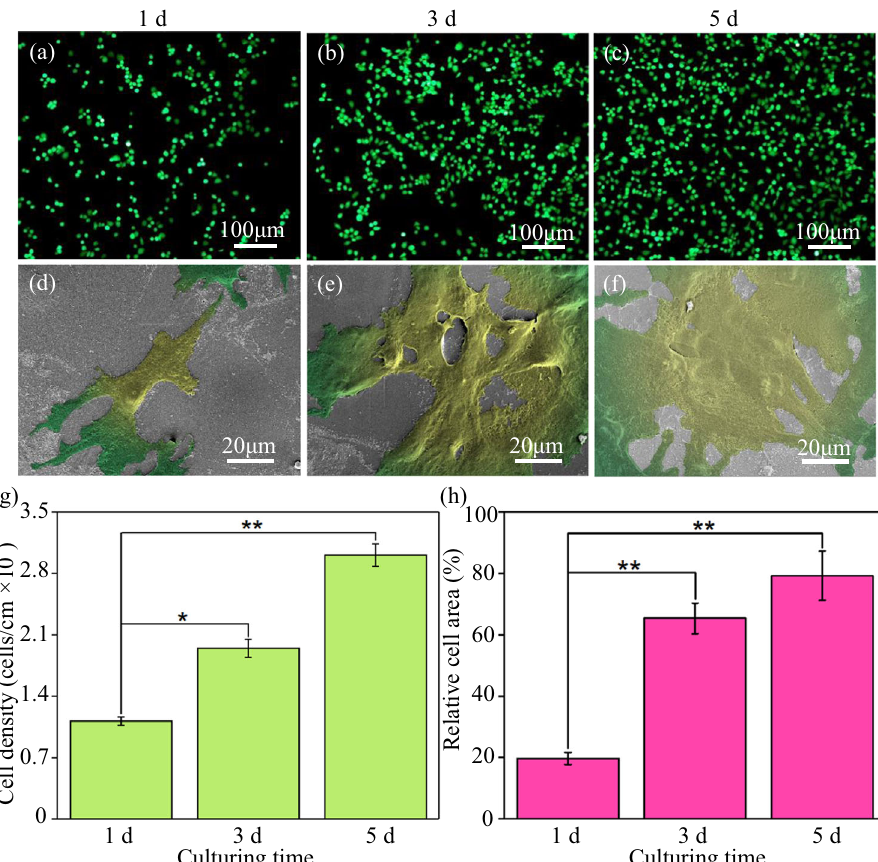
Fig. 7 Cytocompatibility of the composite scaffold. Fluorescence images of MG-63 cells cultured on PLLA/15BCF scaffold for ( a ) 1 d, ( b ) 3 d and ( c ) 5 d, cell adhesion morphologies of MG-63 cells cultured on the PLLA/15BCF scaffold for ( d ) 1 d, ( e ) 3 d and ( f ) 5 d, statistical results of ( g) cell density and ( h ) relative cell area. * was evaluated via the t-test and indicated the statistical difference (* p < 0.05, * *p < 0.01) compared with the group cultured for 1 d. The error bars represent the standard deviations from four independent